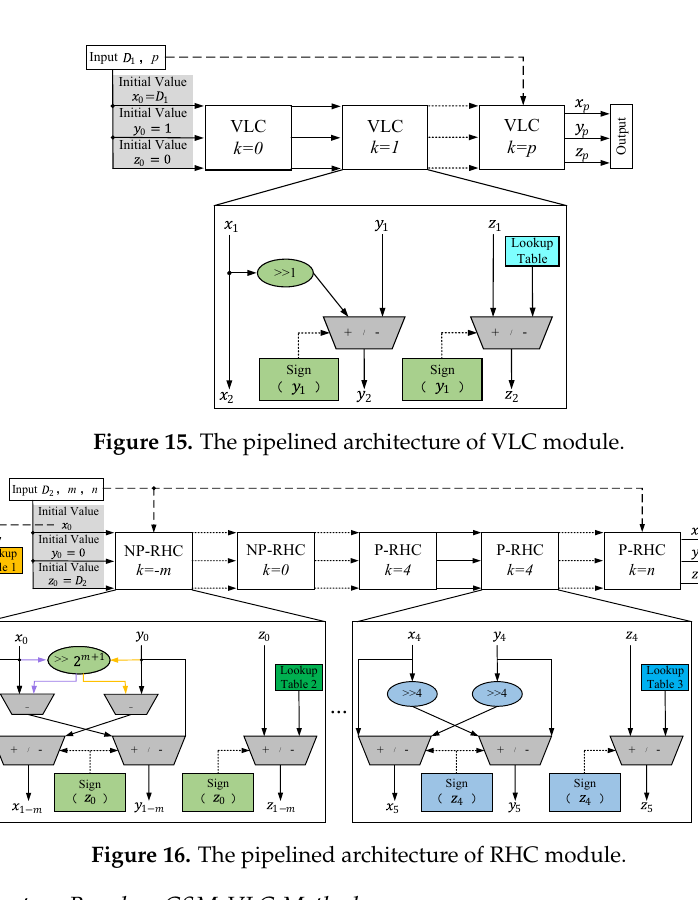
Figure 16. The pipelined architecture of RHC